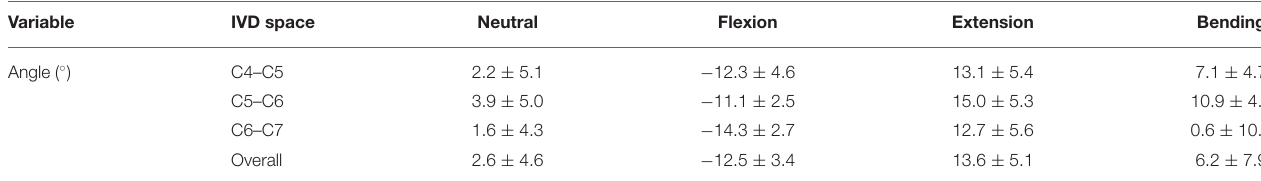
TABLE 3 | IVD wedge angles (means ± SD) of the different segments and the different motion extremes in small dogs.